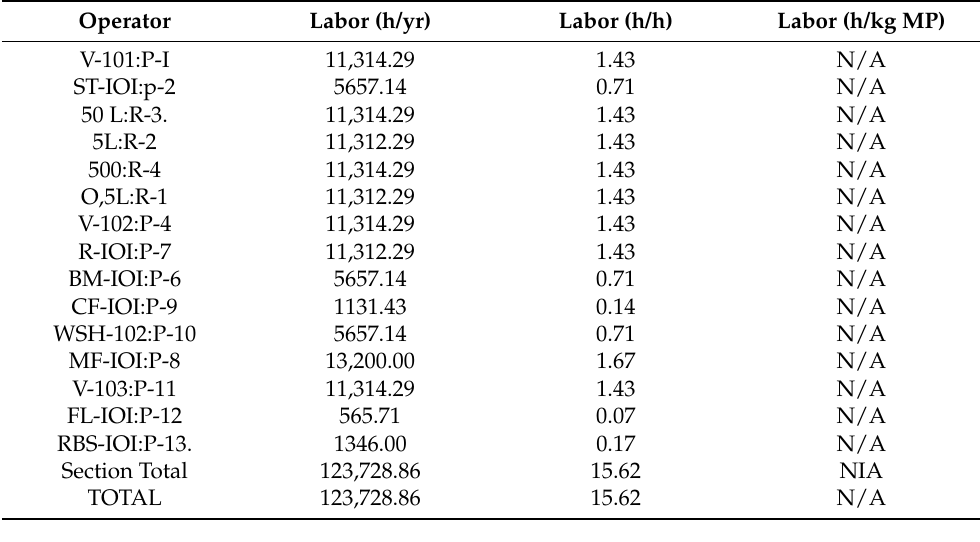
Table 4. Equipment’s Purchase (Cost).